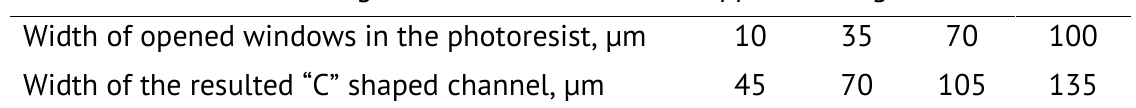
Correlation between width of opened windows in the photoresist and expected width of the “C” shaped channel.